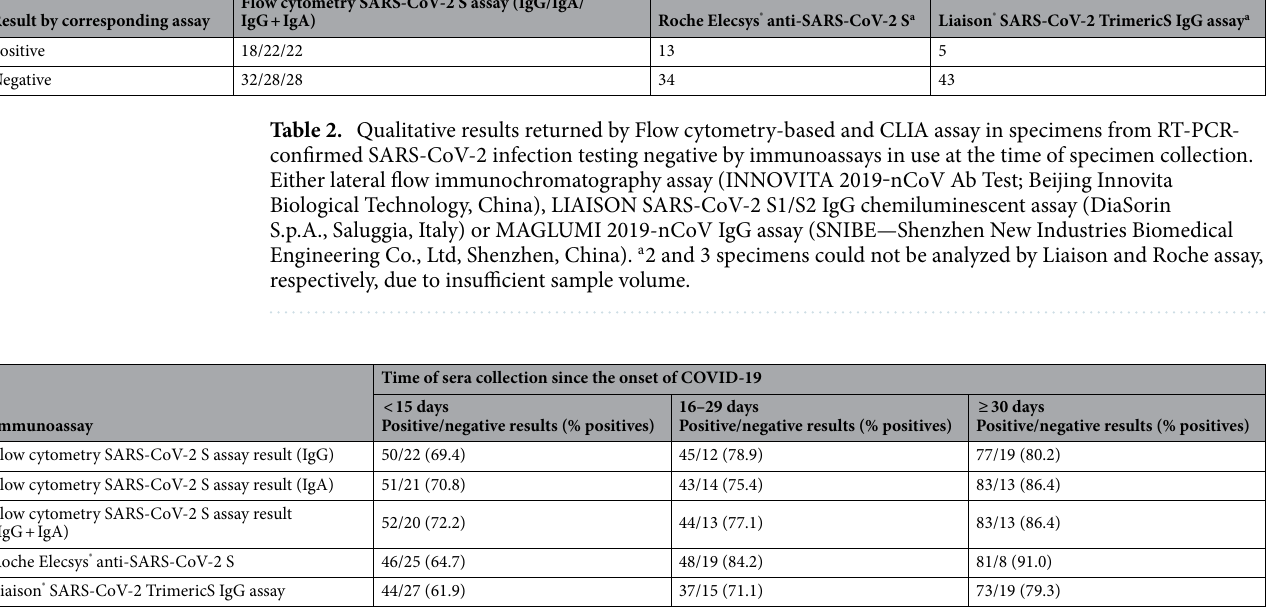
Table 3. Performance of a flow cytometry-based S immunoassay and two commercially-available SARS- CoV-2 CLIA targeting either the trimeric S protein or the receptor binding domain (RBD) according to the time of sample collection since the onset of COVID-19